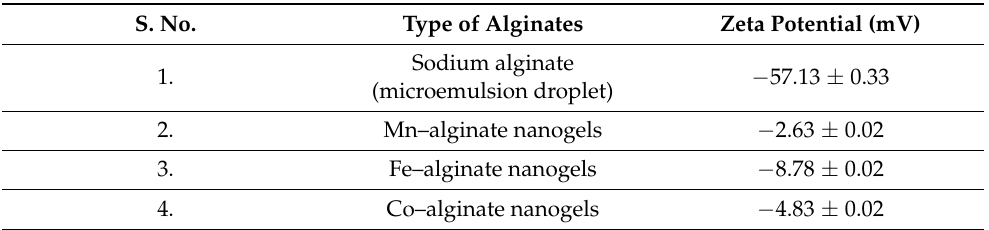
Table 3. Zeta potentials of linear sodium alginate chain and alginate nanogels cross-linked with divalent cations (Mn 2+ , Fe 3+ , and Co 2+